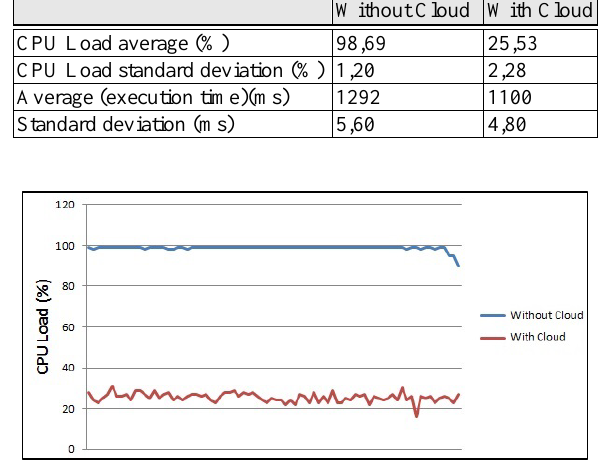
Figure 6. CPU Load in exhaustive case , with and without cloud support.